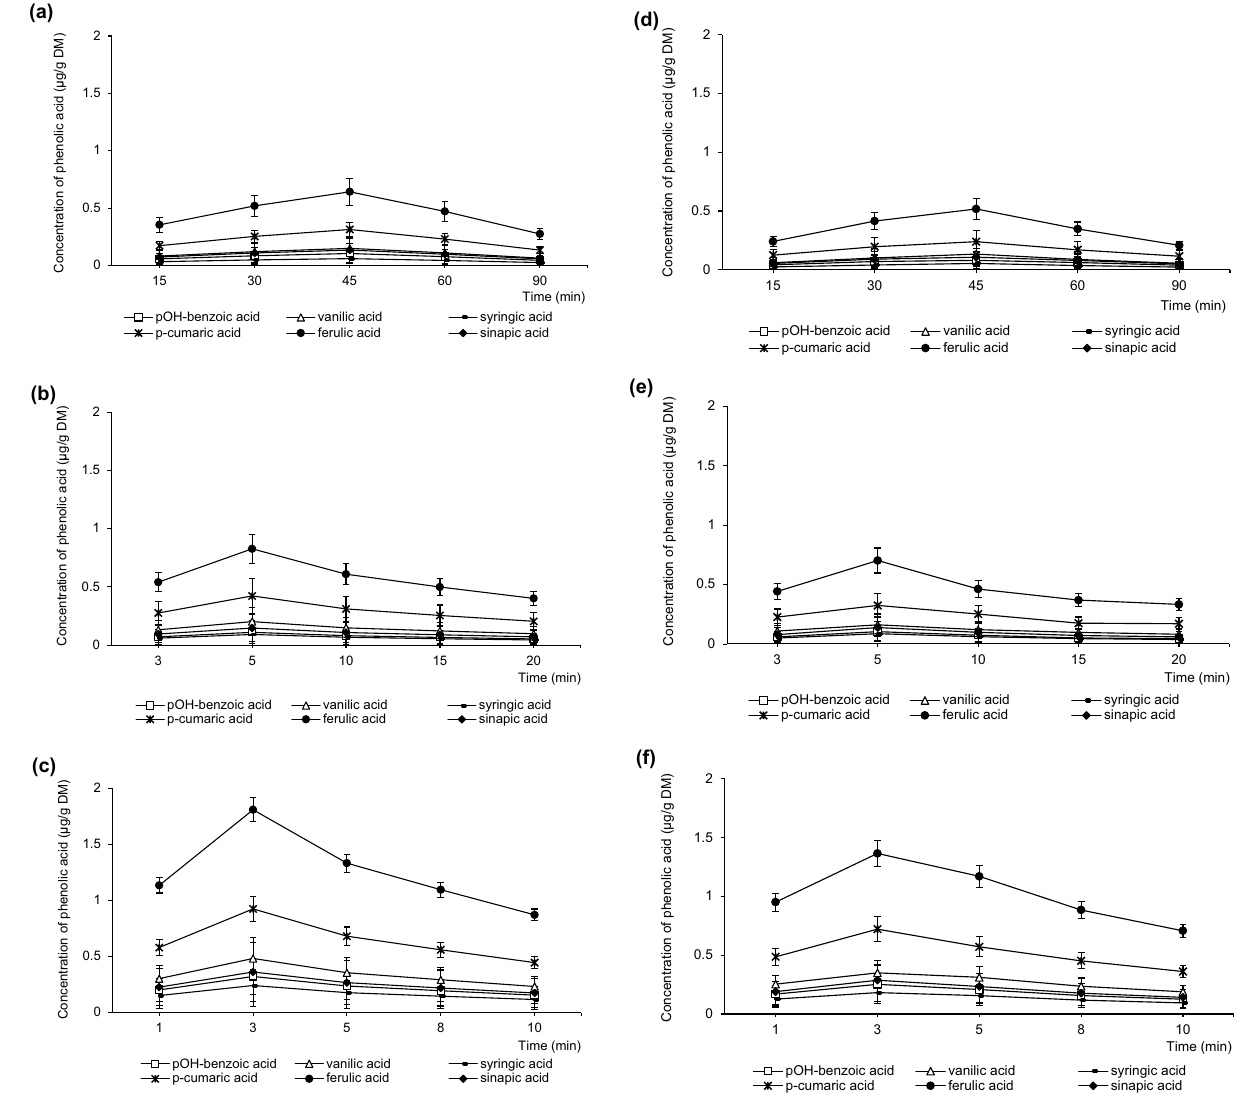
Figure 2. Concentrations of free phenolic acids in extracts obtained with ( a ) CSLE E80, ( b ) UAE E80, ( c ) MAE E80, ( d ) CSLE M80, ( e ) UAE M80, ( f ) MAE